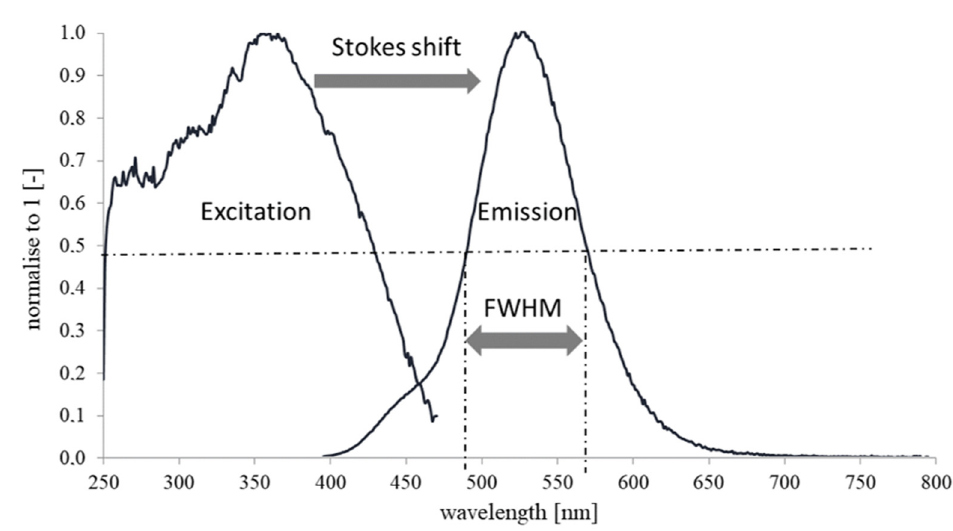
Figure 2. Explanation of the most important optical parameters in the UV to visible light conversion process.